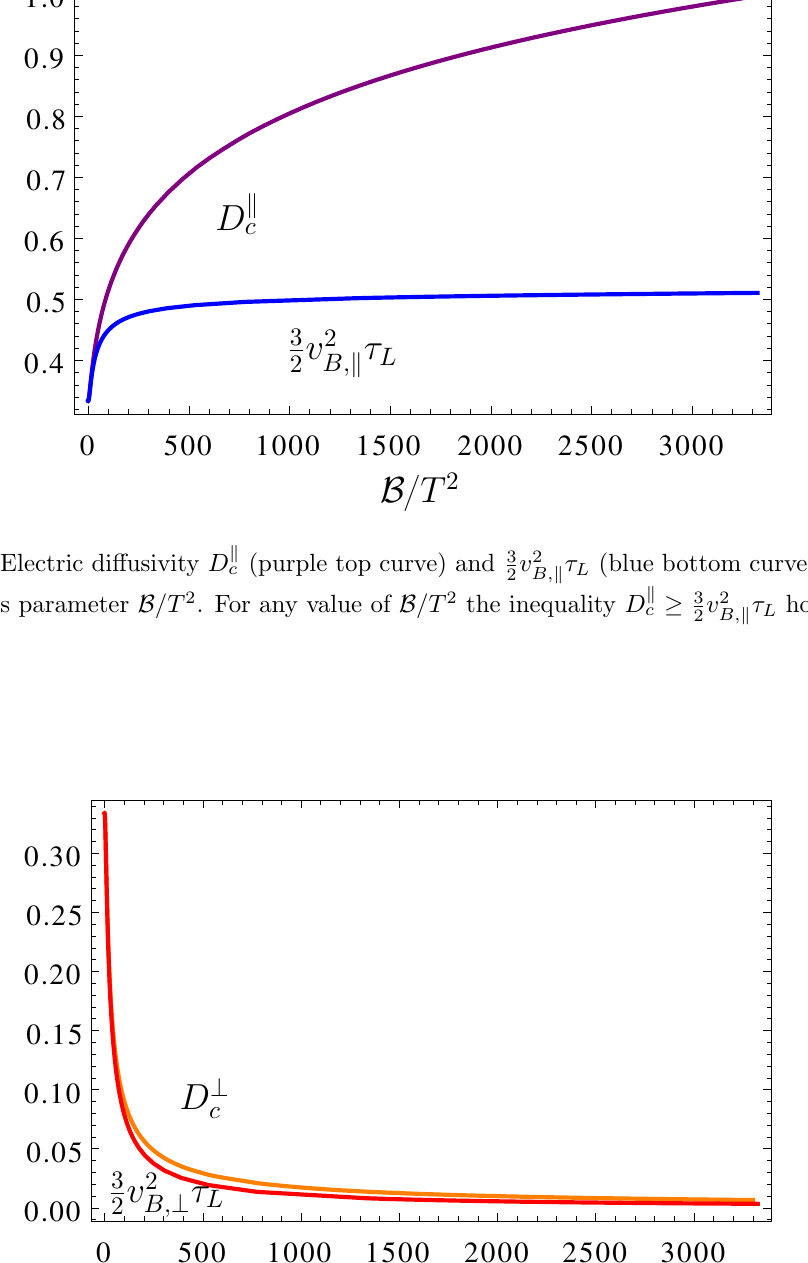
(orange top curve) and 3 c =T 2 . For any value of B